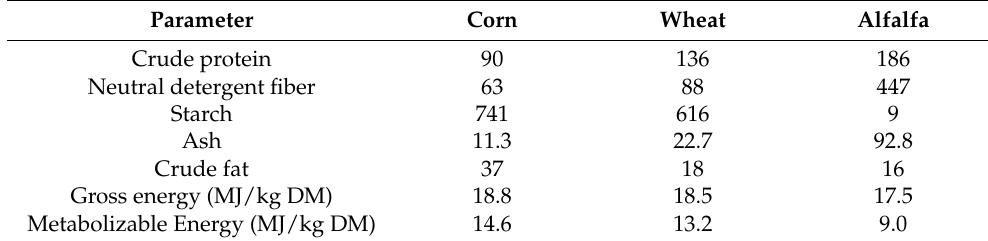
Table 1. Composition of main dietary ingredients (g/kg DM unless otherwise stated). Parameter Corn Wheat Alfalfa Crude protein 90 136 186 Neutral detergent fiber